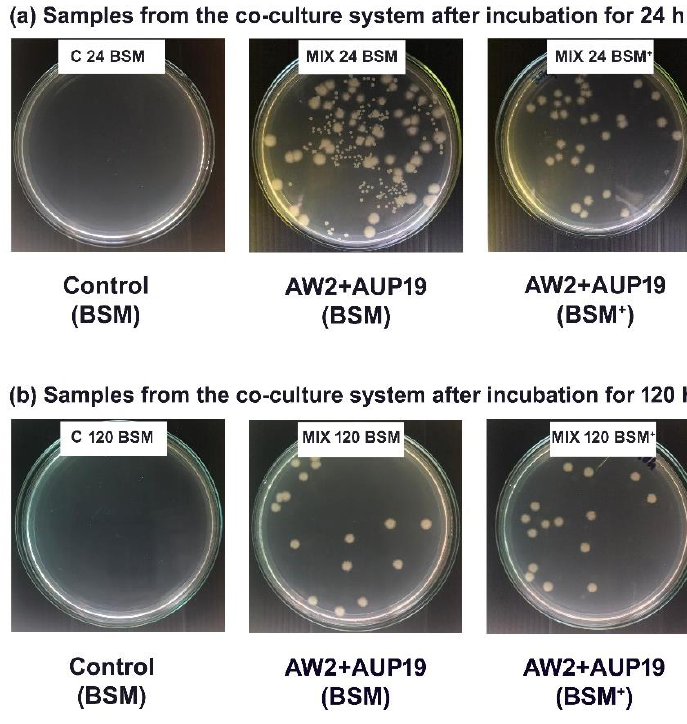
Figure 6. Cell-bound lipase (CBL)-producing strains observation on the agar plates (BSM agar and BSM + containing 10% ( v / v ) tartaric acid agar plates). Tartaric acid was used to inhibit bacterium growth to observe the pattern of yeast growth. The samples were taken from the co-culture system at 24 h ( a ) and 120 h ( b ) and serially diluted to 10 −7 before inoculation on agar medium. Table 6. Fatty acid methyl esters (FAME) from esterification and transesterification reactions by the CBLs obtained from co-culture of M. spicifer AW2 and S. hominis AUP19 in the optimized and non-optimized media [5] at 24, 48, 72, and 96 h of reaction time, vigorous shaking at 300 rpm, and room temperature (30 ± 2 ◦ C).